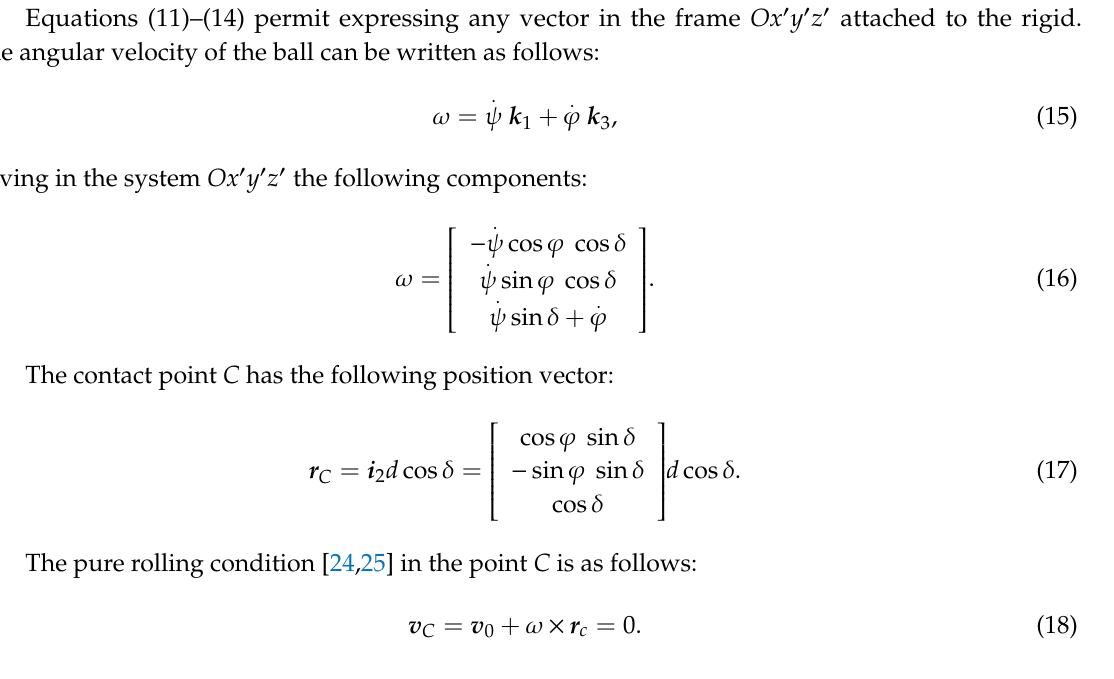
Figure 8. Schematics for the kinematic and dynamic study.